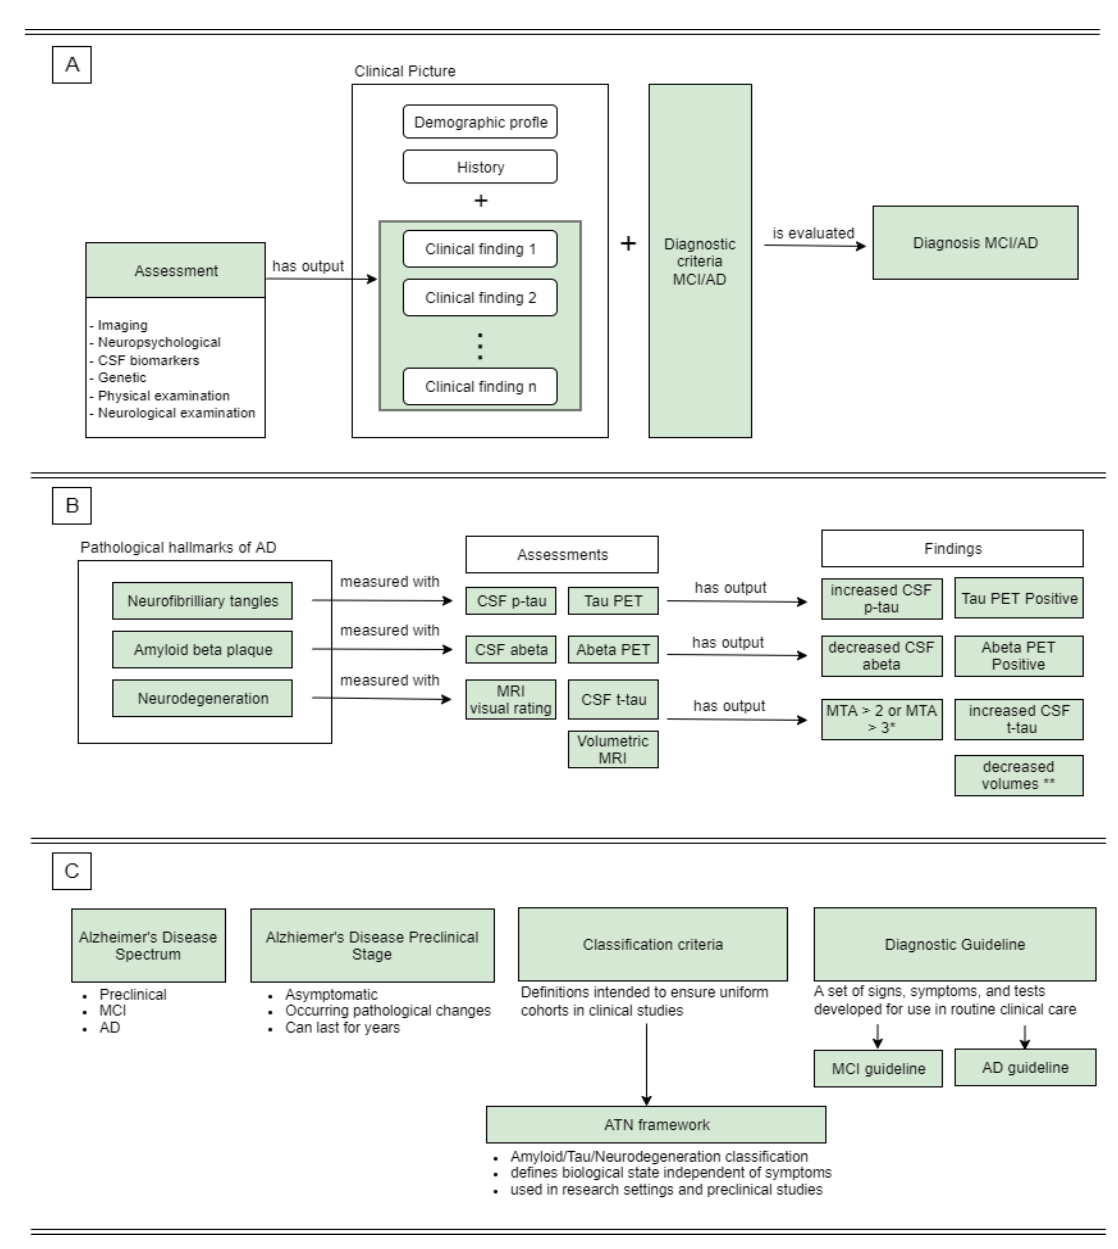
Figure 2. Visual representation of the key concepts and relations in AD-DPC. All rectangles represent concepts, and all arrows represent relations. The text under the concepts represents their definitions and descriptions in AD-DPC. Part ( A ) depicts the temporal sequence of the diagnostic process for MCI and AD. Part ( B ) shows the process of detecting pathological features of AD. Part ( C ) shows concepts that do not form rich taxonomies.